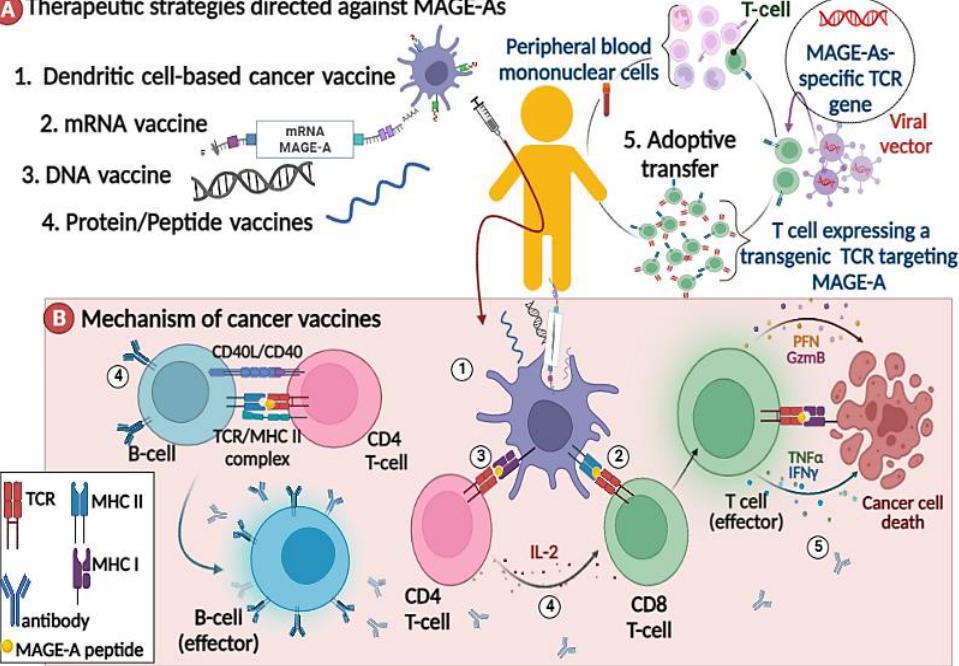
Figure 2. Schematic depiction of therapeutic strategies. ( A ) and their mechanisms ( B ) directed against MAGE-A antigens. ( A ) Many types of MAGE-directed cancer immunotherapy have been developed, including protein or peptide vaccines, DNA or RNA vaccines, cell-based vaccines, and adoptive T cell therapy. ( B ) The immune response to a cancer vaccine consists of several steps: ① Antigen-presenting cells (APC) capture injected MAGE-As, whether DNA, RNA, or peptides, and present them to stimulate CD8 T cells ② via MHC I, and helper CD4 T cells ③ via MHC II. ④ Activated CD4 T cells coordinate immune responses by communicating with other cells and inducing B cells to differentiate into plasma cells. ⑤ Finally, effector T cells, B cells, antibodies, and some cytokines have either a direct or indirect antitumor effect on cancer cells [50].